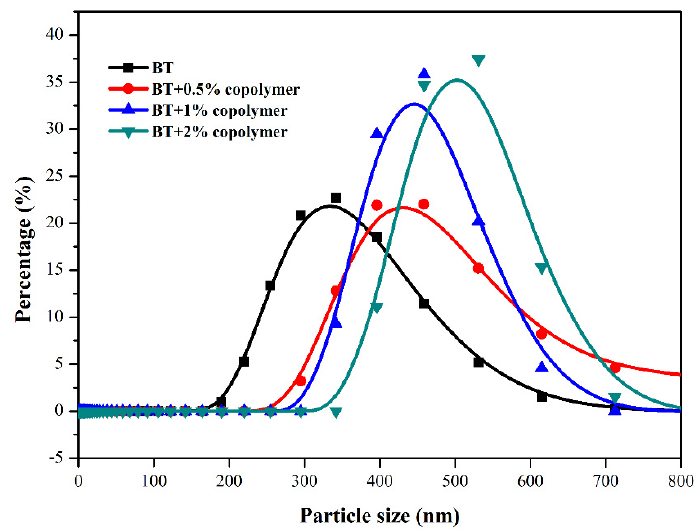
Figure 11. Particle size distribution of clay suspension with different concentrations of the copolymer.